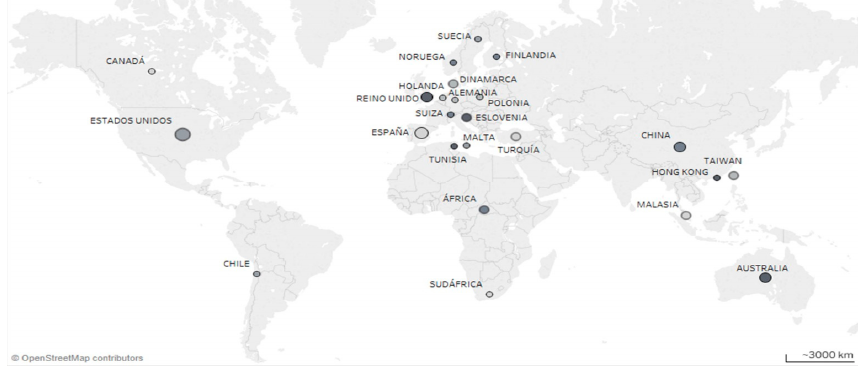
Figure 2. Geographic location and frequency of publication on the research topic. Own elaboration.